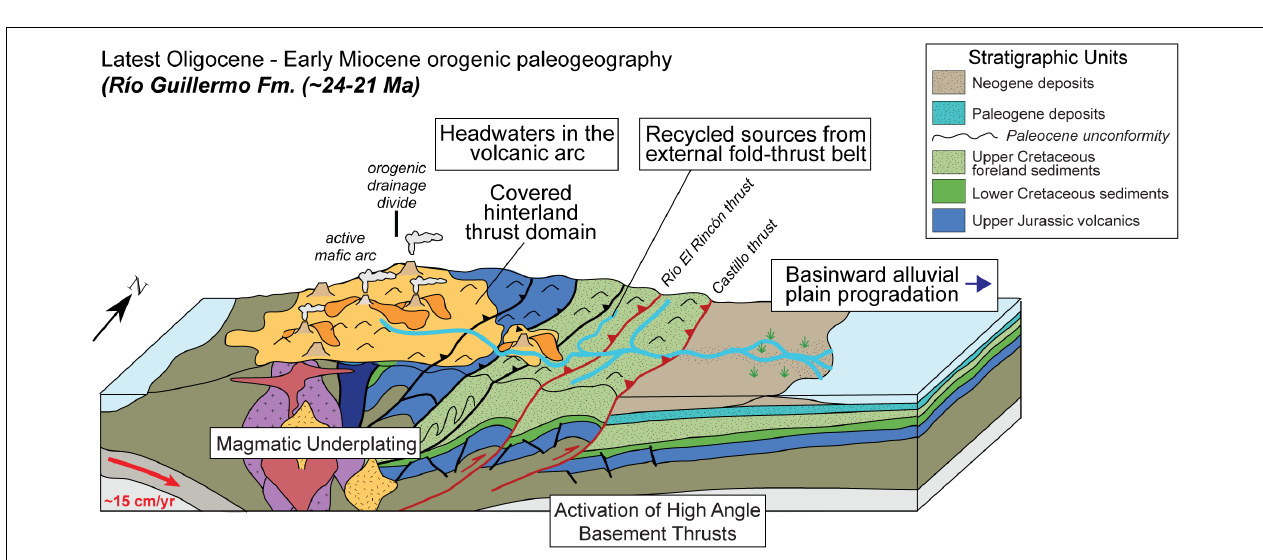
FIGURE 7 | (A) Outcrop photograph of the disconformable contact between the Río Guillermo Formation and underlying upper Río Turbio Formation at the Cancha Carrera study locality. (B) Changes in eustatic sea level during deposition of the foreland basin deposits in our study area. Sea level data from Miller et al. (2005). Convergence rates between the South America and Farallon plates for 49 ◦ S from Somoza and Ghidella (2012). Timing of faulting in the external fold-and-thrust belt from Fosdick et al. (2011). Depositional ages from Fosdick et al. (2015, 2019), and references therein. The erosional unconformity between the Río Turbio and Río Guillermo formations corresponds in time and duration to a long-term drop in eustatic sea level.